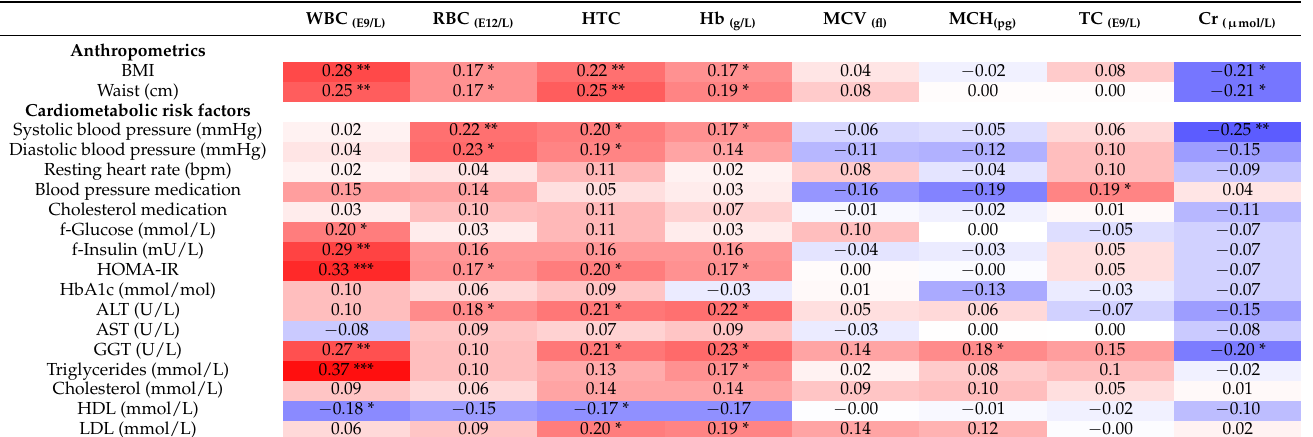
Table 2. Heatmap of age- and sex-adjusted Pearson partial correlation coefficients between anthropo- metrics, cardiometabolic risk factors and common blood parameters (model